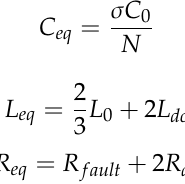
Figure 4. ( a ) Equivalent AC grid feeding current circuit, ( b ) equivalent SM capacitor discharging